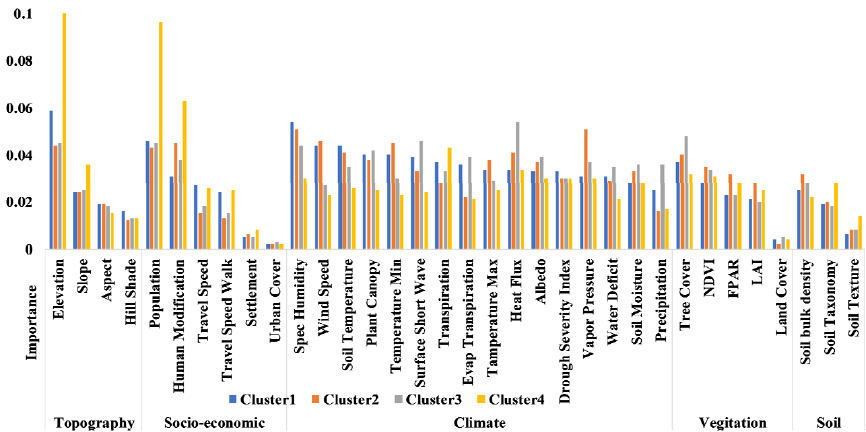
Figure 24. Spatial variable importance analysis based on the RF model.